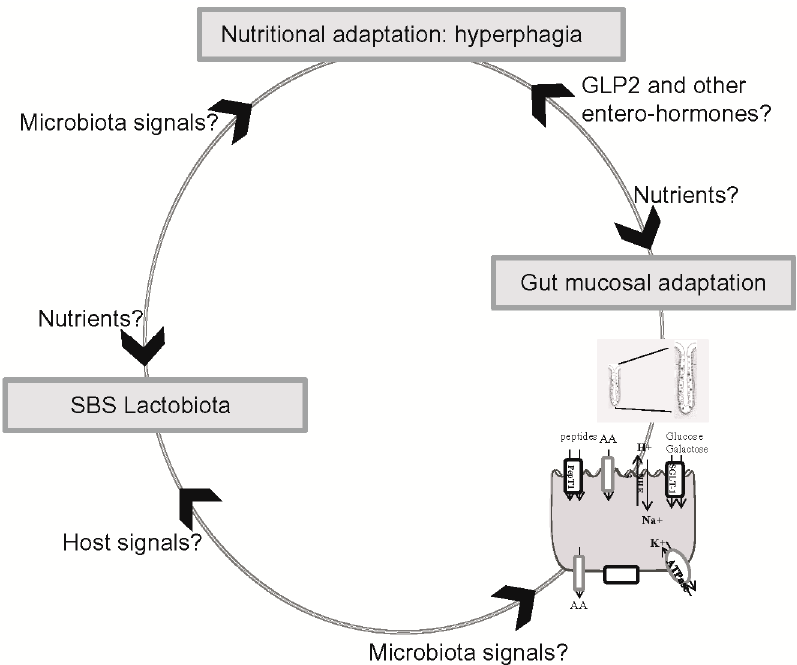
Figure 2. What are the signals involved in the control of food intake, modification of the intestinal mucosa and the lactobiota in SBS?